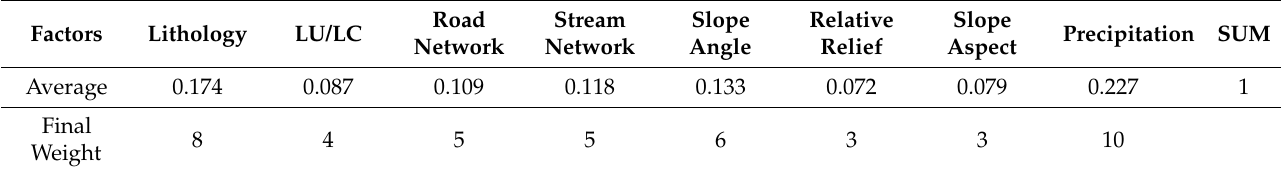
Table 3. Determining the final weights of the causal